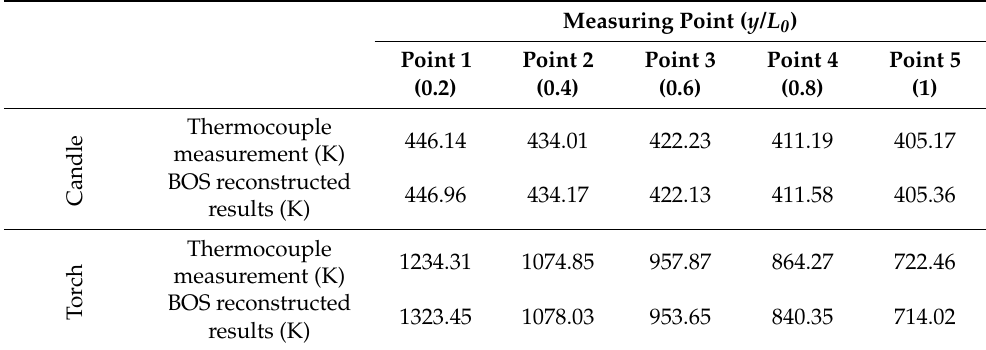
Figure 3. Temperature field obtained by the implemented background-oriented schlieren method for two different convective flows ( a ) burning candle; ( b ) blow torch. Table 1. Comparison between the thermocouple temperature measurements and the reconstructed temperature field obtained by the BOS technique.